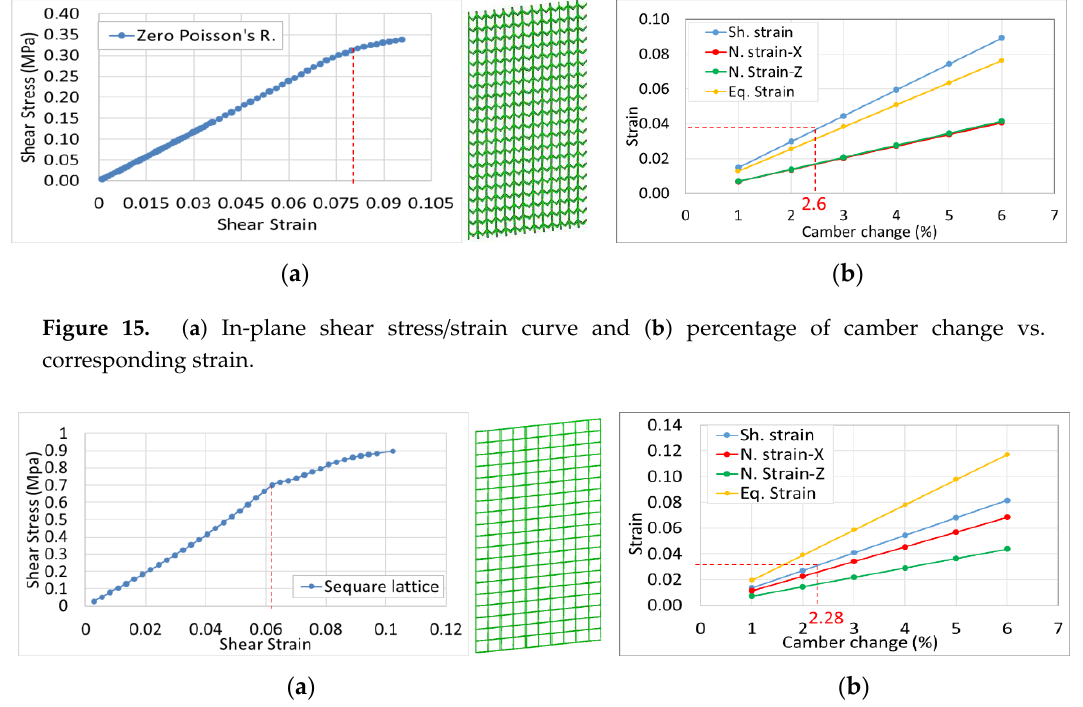
Figure 16. ( a ) In-plane shear stress/strain curve and ( b ) percentage of camber change vs. corresponding strain.